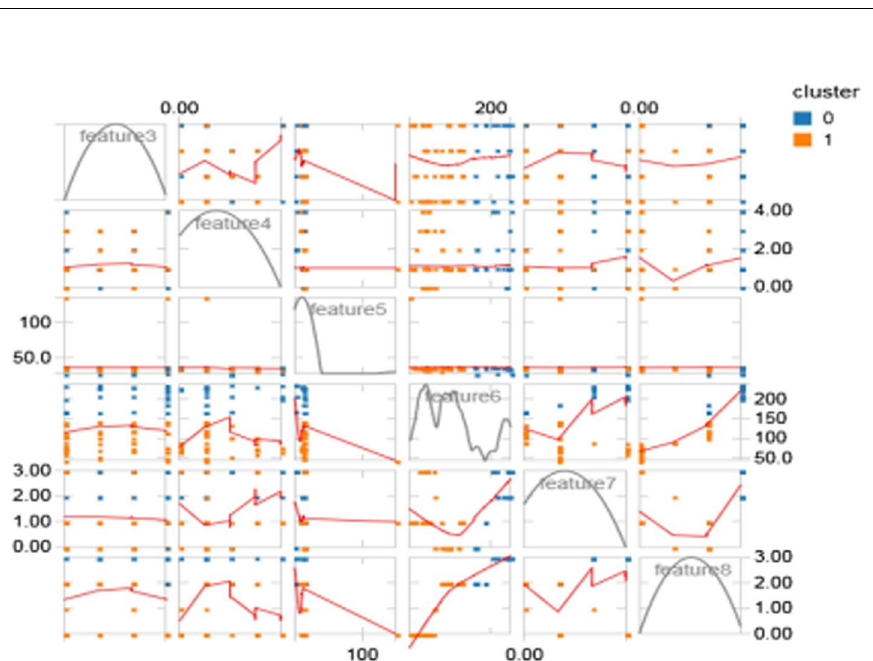
Fig. 7 Scatter Plot for 2 clusters and 11 risk